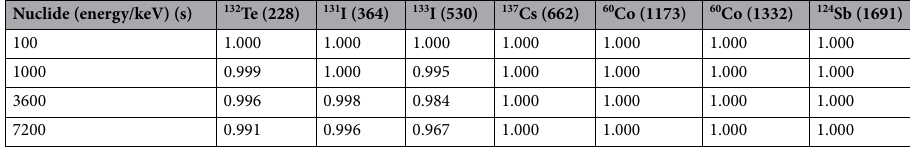
Table 6. Decay correction factors K for detection models.